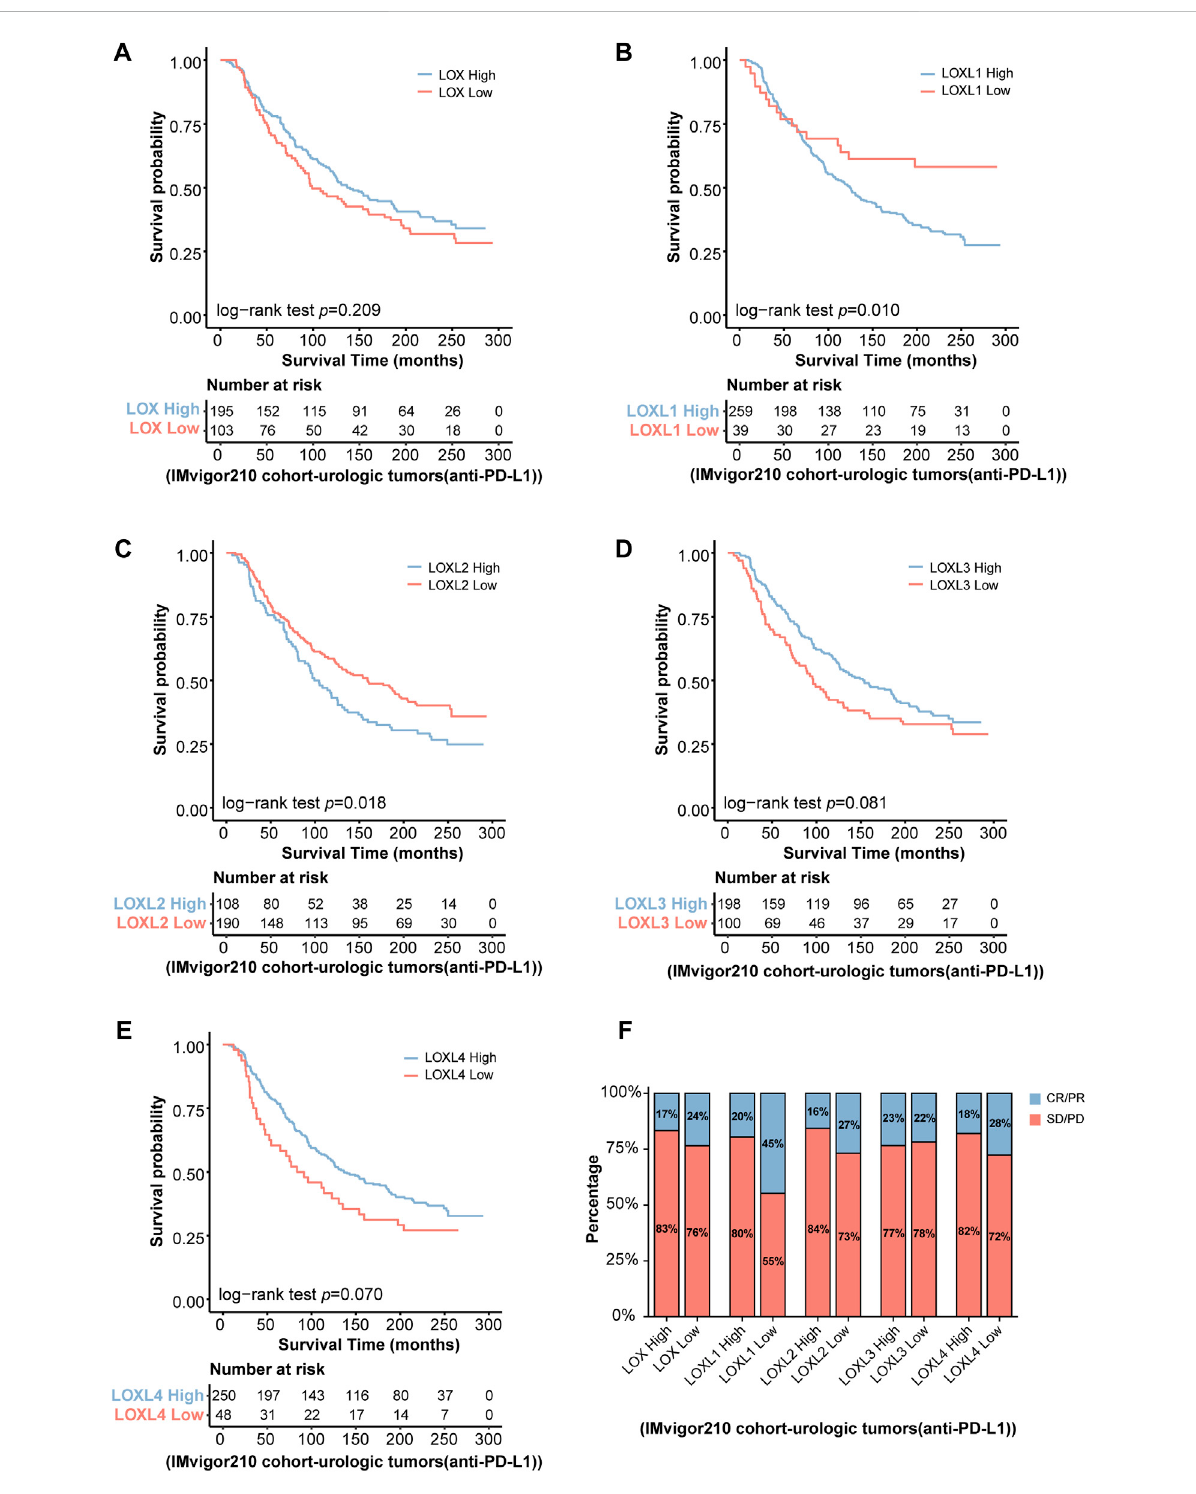
FIGURE 10 Validation of the predictive roles of LOXs in tumor immunotherapy in IMvigor 210 cohort. (A – E) Indicates the patients ’ survival following anti- PD-L1 treatment according to distinct LOXs expressions in IMvigor 210 cohort; (F) shows the fraction of urologic tumor patients with response to anti-PD-L1 therapy in high- and low-LOXs subgroups of IMvigor 210 cohort. CR, complete response; PR, partial response; SD, stable disease; PD, progressive